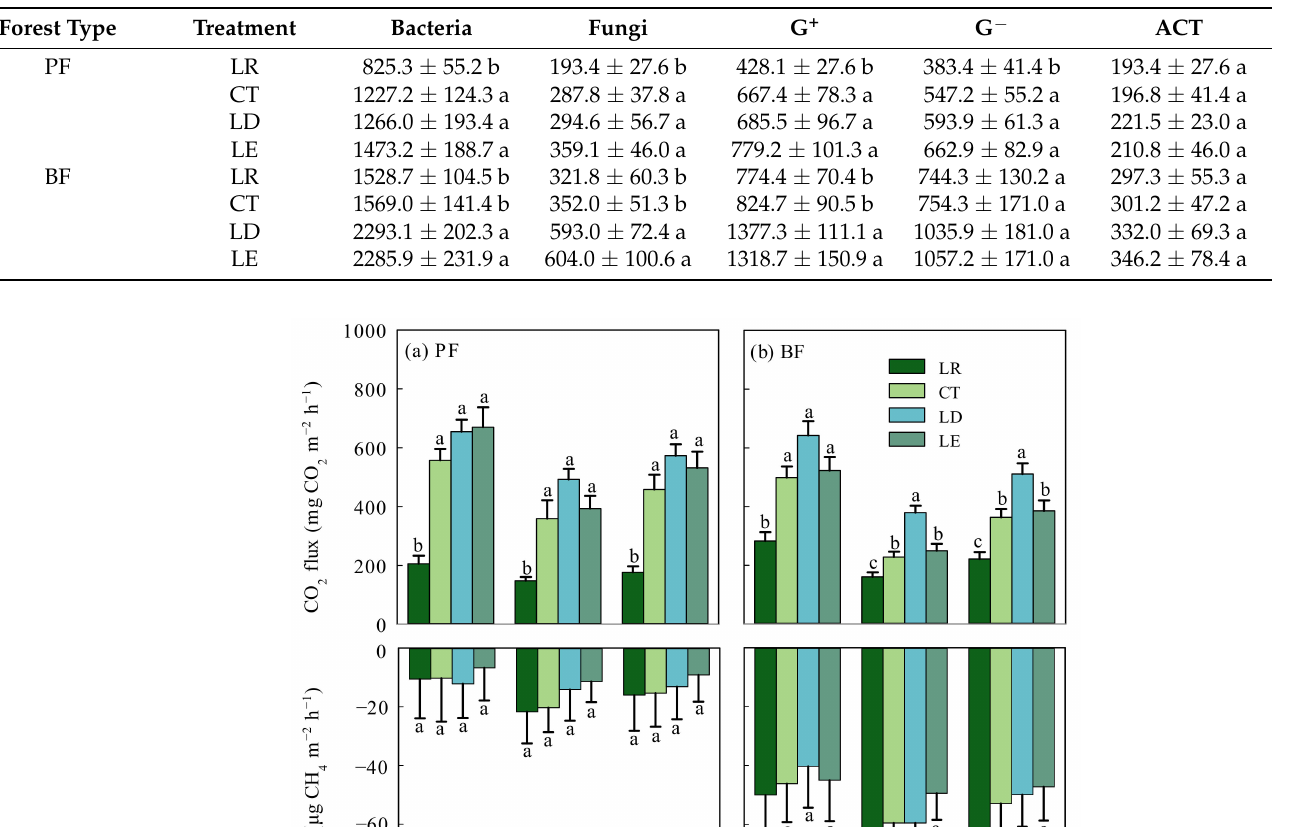
Table 3. Soil microbial phospholipid fatty acids (PLFAs) content (ng g − 1 ) in PF (Masson pine forest) and BF (evergreen broadleaved forest) exposed to different litter manipulation treatments from August 2012 to July 2013. Data are shown by mean ± se. Different lowercase letters indicate significant differences between treatments in each forest ( p < 0.05). LR = litter removal; CT = control; LD = litter doubling; LE = litter exchange; G + =gram-positive bacteria; G − = gram-negative bacteria; ACT = Actinomycetes.